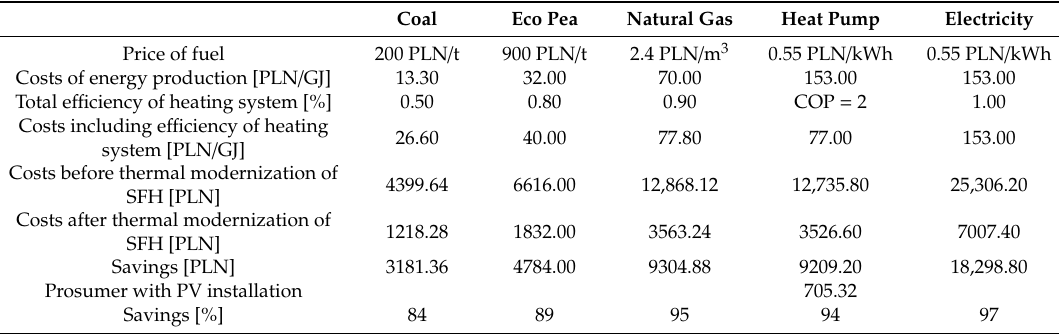
Table 2. Analysis of the heating costs of a SFH with a flat roof, the so-called “cube”.